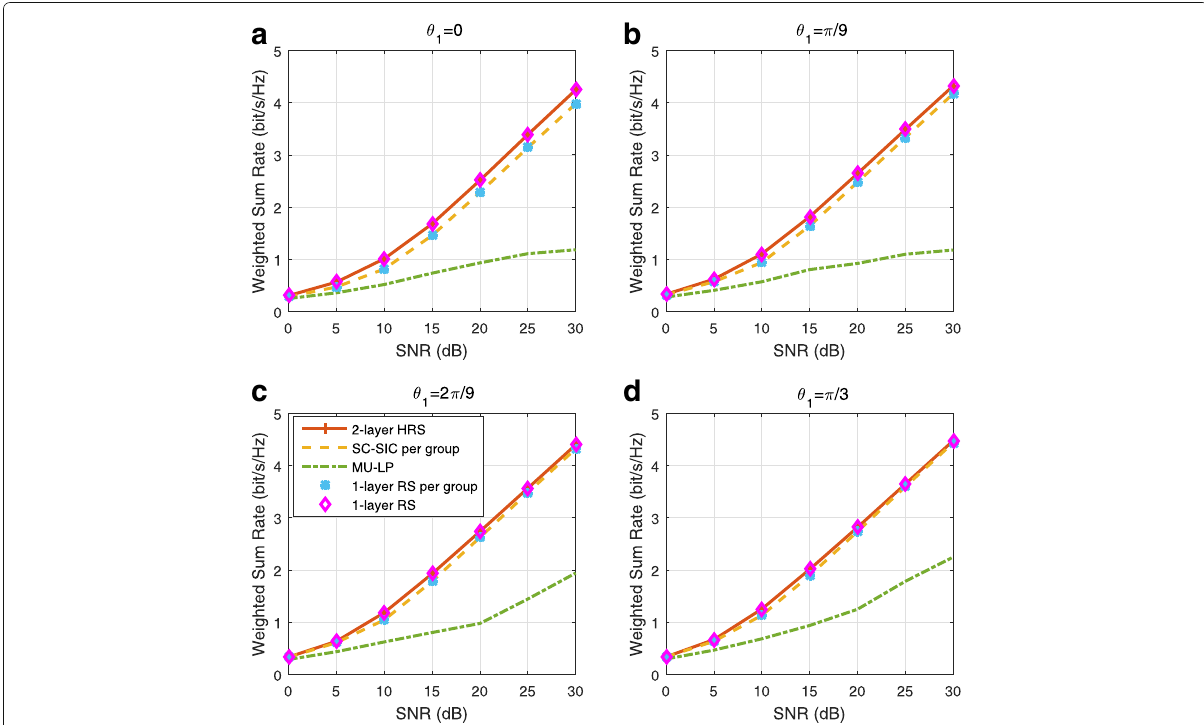
Fig. 19 Weighted sum rate versus SNR comparison of different strategies for overloaded four-user deployment with perfect CSIT, γ 1 = 0.3, = θ + π θ , r th = [0.03,0.1,0.2,0.3,0.4,0.4,0.4] bit/s/Hz. a θ 1 = 0. b θ 1 = π/ 9. c θ 1 = 2 π/ 9. d θ 1 = π/ 3 2 1 3